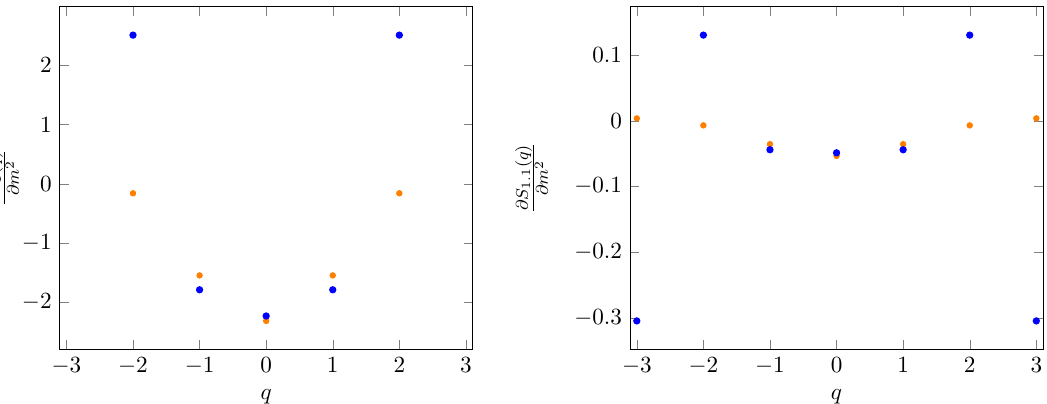
Figure 6 . Mass correction to the logarithm of the charged moment log( Z m for a subsystem of size r = 0 . 5 L in a system of N = 300 sites. This quantity is evaluated for n = 1 . 5 , in the spin sector ν = 2 (left), and for n = 1 in the spin sector ν = 3 (right). The plots have been overlapped thanks to a multiplicative constant obtained by a subsystem-size fit like the one shown in figure 5. In particular, the blue points correspond to the analytical prediction in eq. (4.15).